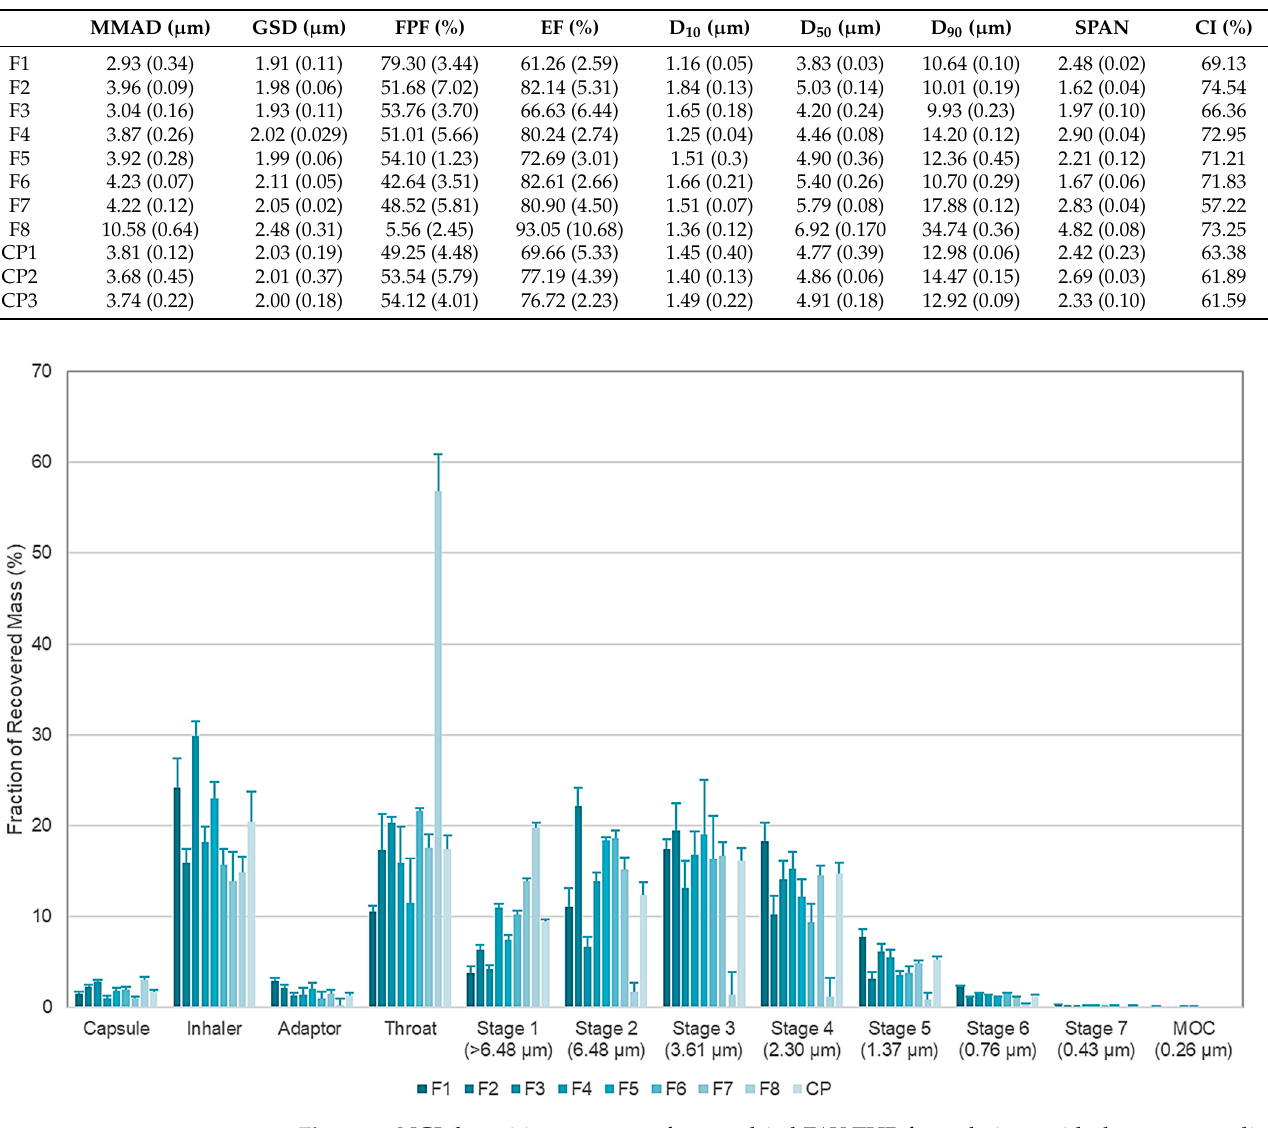
Table 4. Aerodynamic size distribution (MMAD, GSD, FPF, and EF), crystallinity index (CI), and volumetric particle size distribution (D10, D50, D90, SPAN) of spray-dried FAV-THP formulations under different processing parameters. N = 3 with standard deviations shown in brackets.